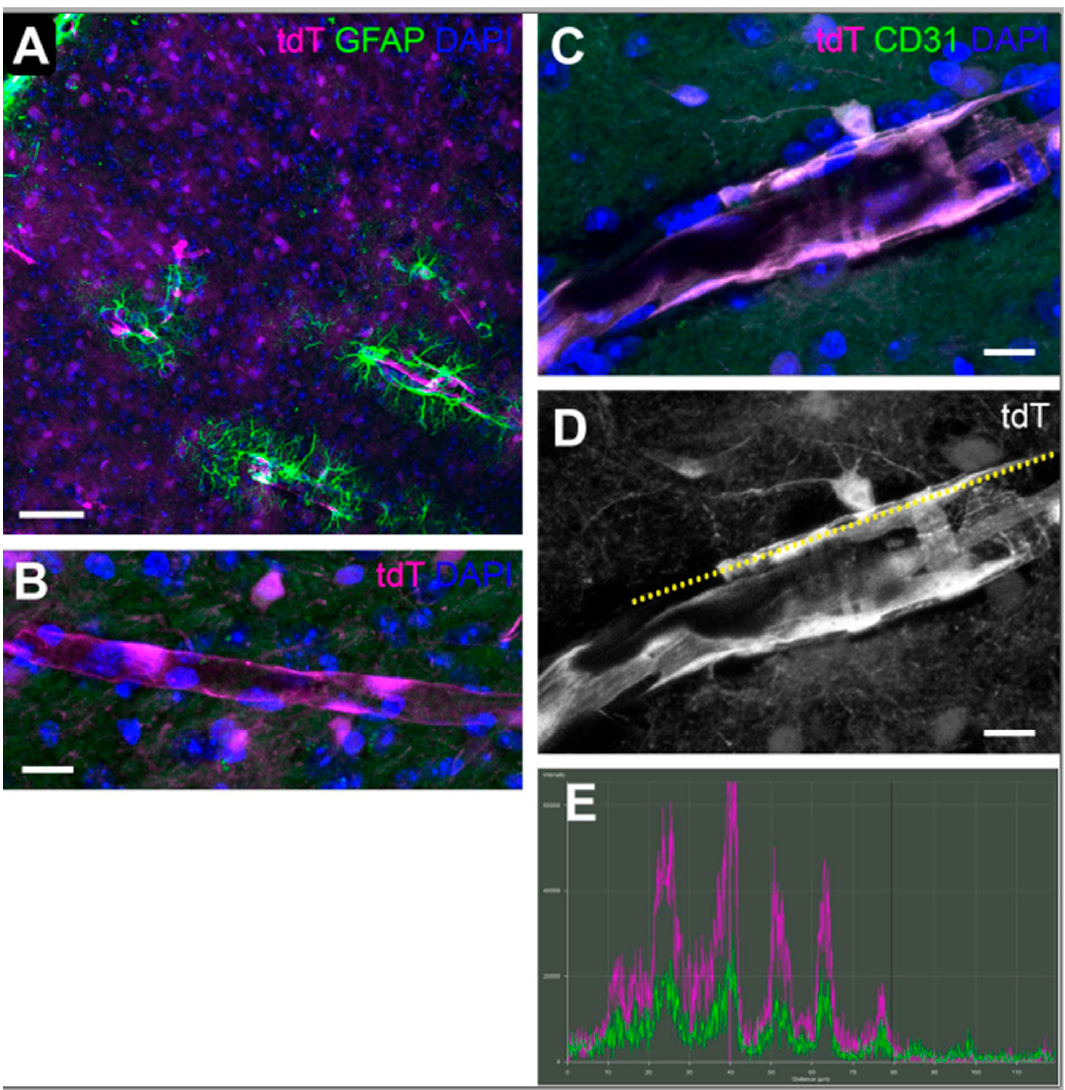
Figure 8. Collicular vasculature is hypoxic 6 h after OHT. ( A ). Immunofluorescence for GFAP (green) in superior colliculus 6h after OHT shows vasculature positive for tdTomato (magenta), indicating ODD stabilization from hypoxia. Cell nuclei labeled with DAPI (blue). 20 × magnification; Scale bar = 100 µ m. ( B ). A collicular vessel positive for tdTomato, 60 × magnification. Scale bar = 20 µ m. ( C ). A larger vessel in the superior colliculus labeled with tdTomato (magenta), endothelial marker CD-31 (green), and nuclear stain DAPI (blue). 60 × magnification. Scale bar = 20 µ m. ( D ). The magenta labeling (alone in grayscale) for the same vessel as ( C ) with a dotted line (yellow) to show the structure drawn to evaluate colocalization of tdTomato with CD-31; results shown in ( E ). ( E ). Colocalization plot for the yellow dotted line in ( D ); magenta is tdTomato and green is CD-31. Peak correspondence indicated colocalization of the two fluorophores within the vessel. Five brains per group and ten sections per brain were analyzed from the 4 time points (6 h, 3 d, 14 d, 28 d).